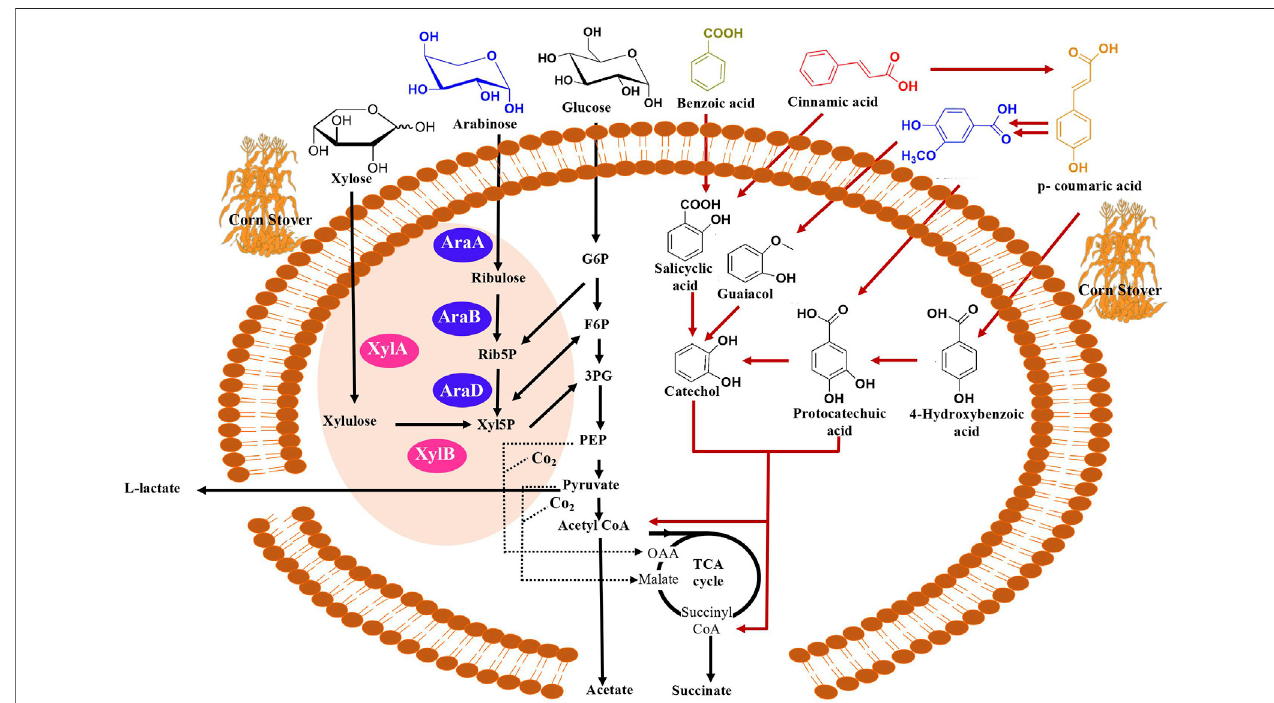
FIGURE 2 | Overview of natural and engineered metabolic pathways for the production of mixed acids (succinate, acetate and lactate) from diverse carbon substrates(xylose,arabinose,glucose,benzoicacid,cinnamicacid,vanillicacid,p-coumaricacid)in C.glutamicum. AssimilationofxylosetobefacilitatedbyXylA(xylose isomerase) and XylB (xylulose kinase) denoted by pink in the fi gure and assimilation of arabinose facilitated by AraA (arabinose isomerase), AraB (ribolokinase) and AraD (ribulose 5-phosphate 4-epimerase) denoted by purple. Abbreviations in arabinose and xylose assimilation Rib5P (ribulose 5-phosphate), Xyl5P (D-xylulose 5- phosphate), G6P (glucose 6-phosphate), F6P (fructose 6-phosphate), 3PG (3-phosphoglycerate). Succinate is synthesized through the reductive branch of TCA cycle from pyruvate orPEP(phosphoenolpyruvate)underanaerobicconditions(Shiraietal.,2007;Thakkeretal.,2012).Acetateissynthesizedfrom acetyl-CoA and